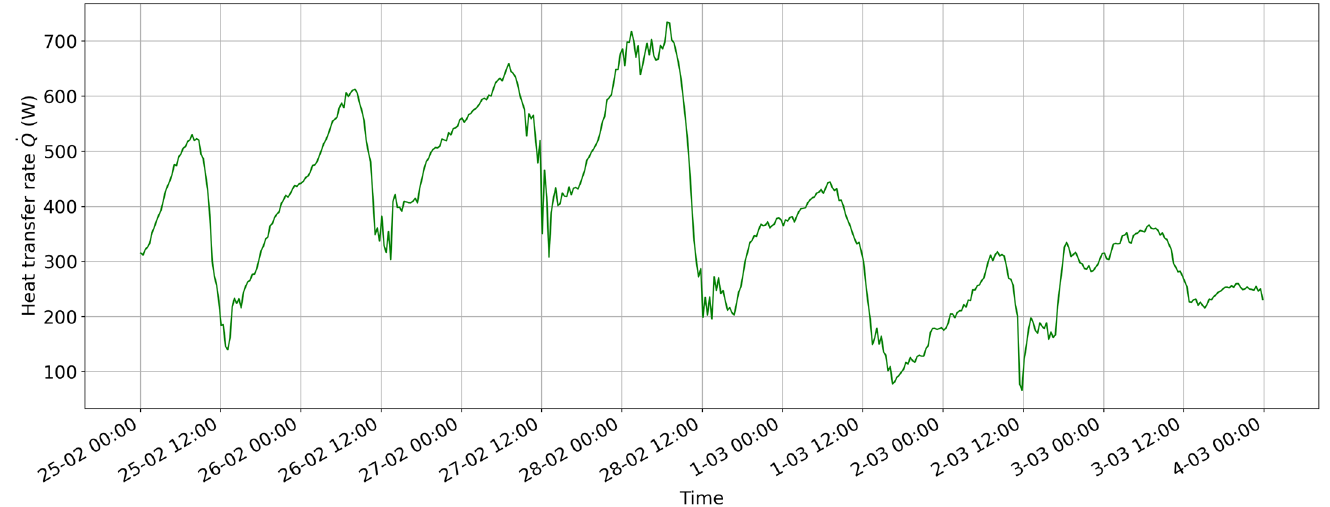
Figure 4. Heat transfer rate gained by the air as passing in the pipe in between the filter and the pipe during the analysis period.